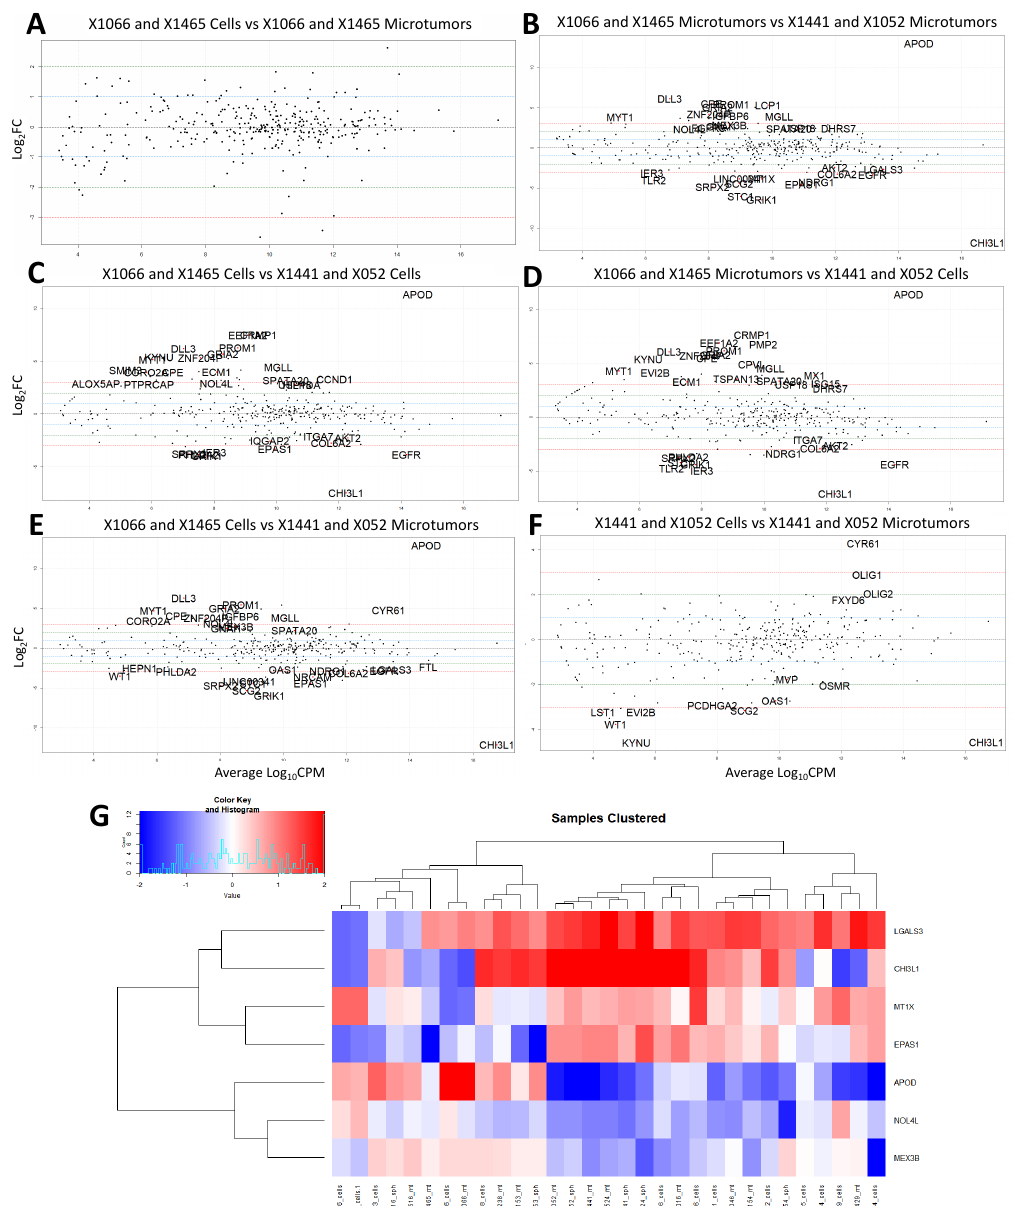
Figure 5. Di ff erential expression of TMZ response concordant (X1066 and X1465) and discordant (X1441 and X1052) tumors: ( A ) X1066 and X1465 Cells vs X1066 and X1465 Microtumors; ( B ) X1066 and X1465 Microtumors vs X1441 and X1052 Microtumors; ( C ) X1066 and X1465 Cells vs X1441 and X052 Cells; ( D ) X1066 and X1465 microtumors vs X1441 and X1052 Cells; ( E ) X1066 and X1465 Cells vs X1441 and X1052 microtumors; ( F ) X1441 and X1052 Cells vs X1441 and X052 Microtumors; ( G ) Seven gene signature from di ff erential expression of concordant microtumors vs discordant microtumors of genes associated with TMZ response. Samples clustered by TMZ response concordance (left) and discordance (right). Significance determined by: p ≤ 0.05 and − 2 ≥ log 2 Fold Change ≥ 2. Log 10 CPM = Log base 10 of counts per